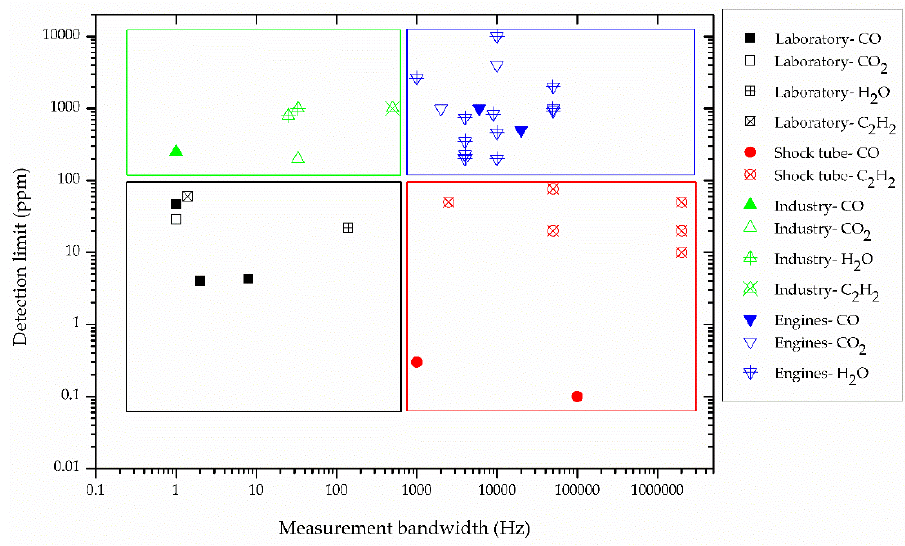
Figure 2. Representative detection limits and measurement bandwidths of laser absorption sensors in various combustion-related systems.